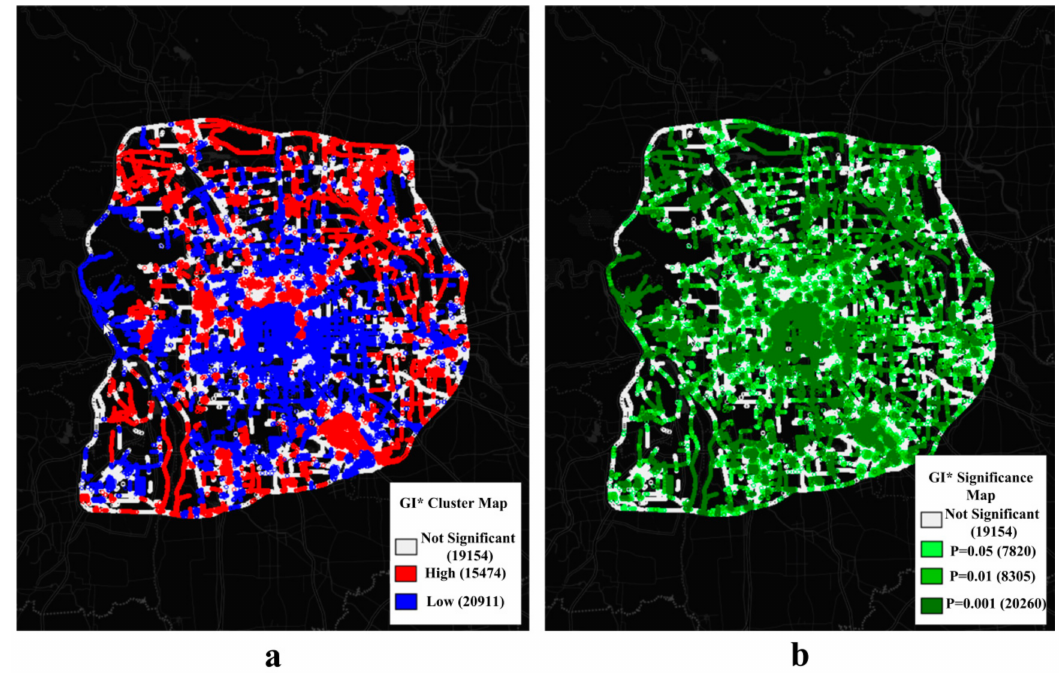
Figure 9. Getis-Ord GI* Cluster and Significance maps of green view index (GVI). Numbers of points are in parentheses. Subplot ( a ) shows the hot and cold spots of GVI in a GI* Cluster Map. Subplot ( b ) shows the GI* Significance Map of GVI values at 0.001, 0.01 and 0.05